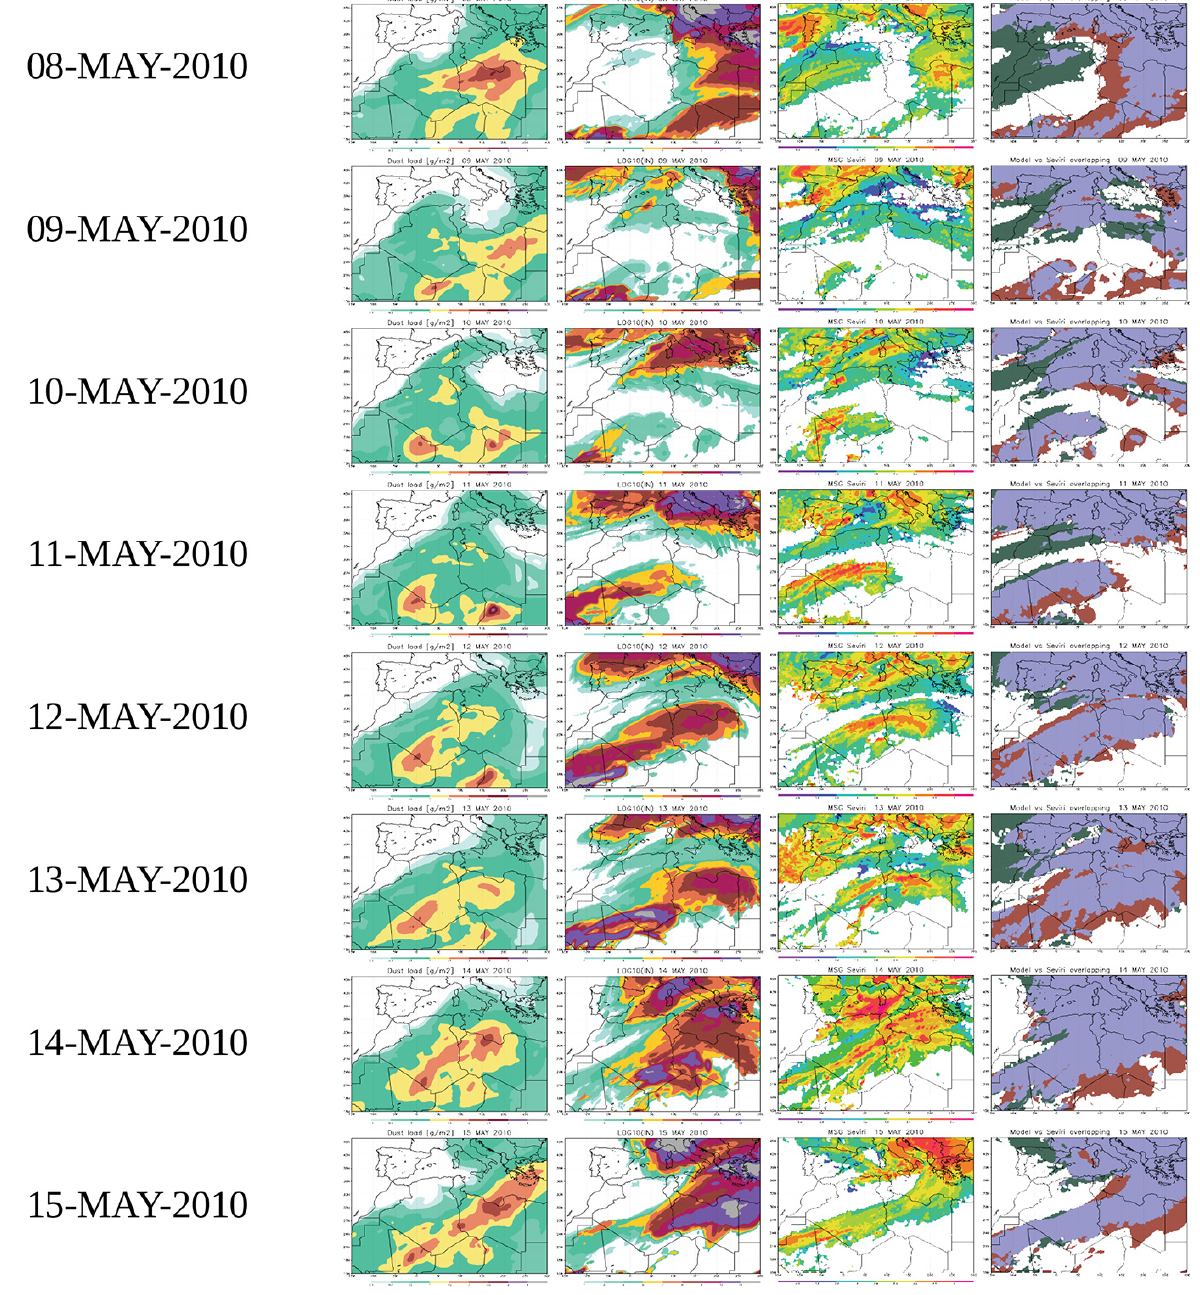
Figure 1. Daily averages of (a) the model dust load (gm − 2 ) , (b) the model NL, (c) the MSG-SEVIRI IWPL, and (d) overlap of normalized NL and IWPL. Colour selection: hits – blue; misses – green; false alarm –